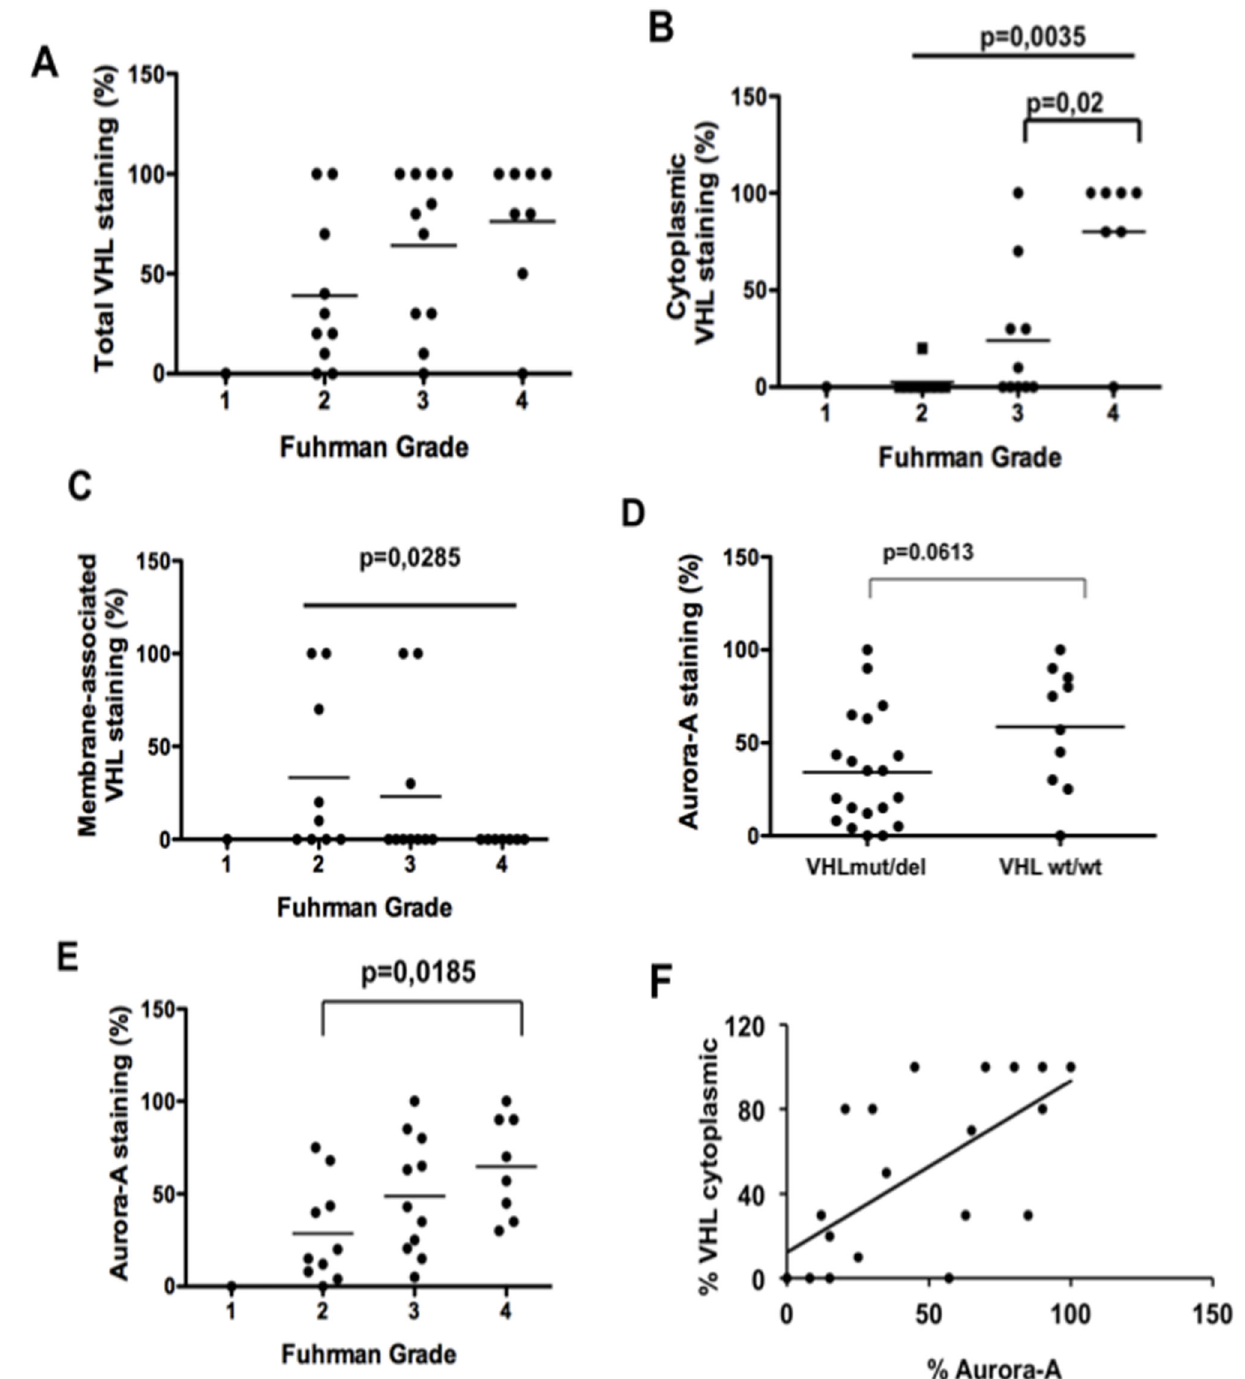
Figure 3. Statistical analysis of Aurora-A and pVHL levels and localization in ccRCCs according to their Fuhrman grade and VHL status. pVHL expression level (A) and localization (B and C) in ccRCCs were analysed relative to the Fuhrman grade of the tumours. Aurora-A expression level was assessed relative to the VHL status (D) and Fuhrman grade (E) of the tumours. Aurora-A expression according to the VHL cytoplasmic localization was also evaluated (F). The non-parametric Mann-Whitney test was used to evaluate the statistical relationships between the expression of Aurora-A and pVHL and the tumour parameters.